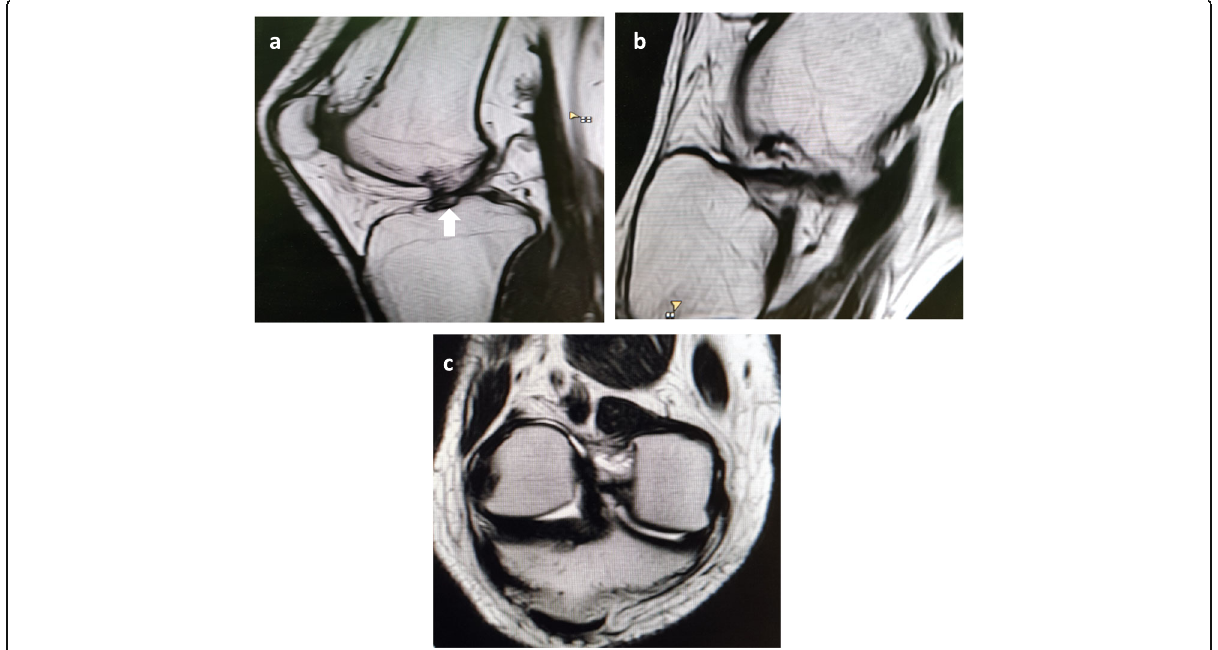
Fig. 2 A female patient, 35 years old, complaining of knee pain following from falling down the stairs. a Sagittal T2 image revealed a focal intrasubstance area of intermediate signal intensity at the site ACL tibial attachment suggesting partial ACL tear (white arrow). b Oblique sagittal and c oblique coronal T2 MRI images revealed a well taut ACL showing normal signal intensity with intact tibial and femoral